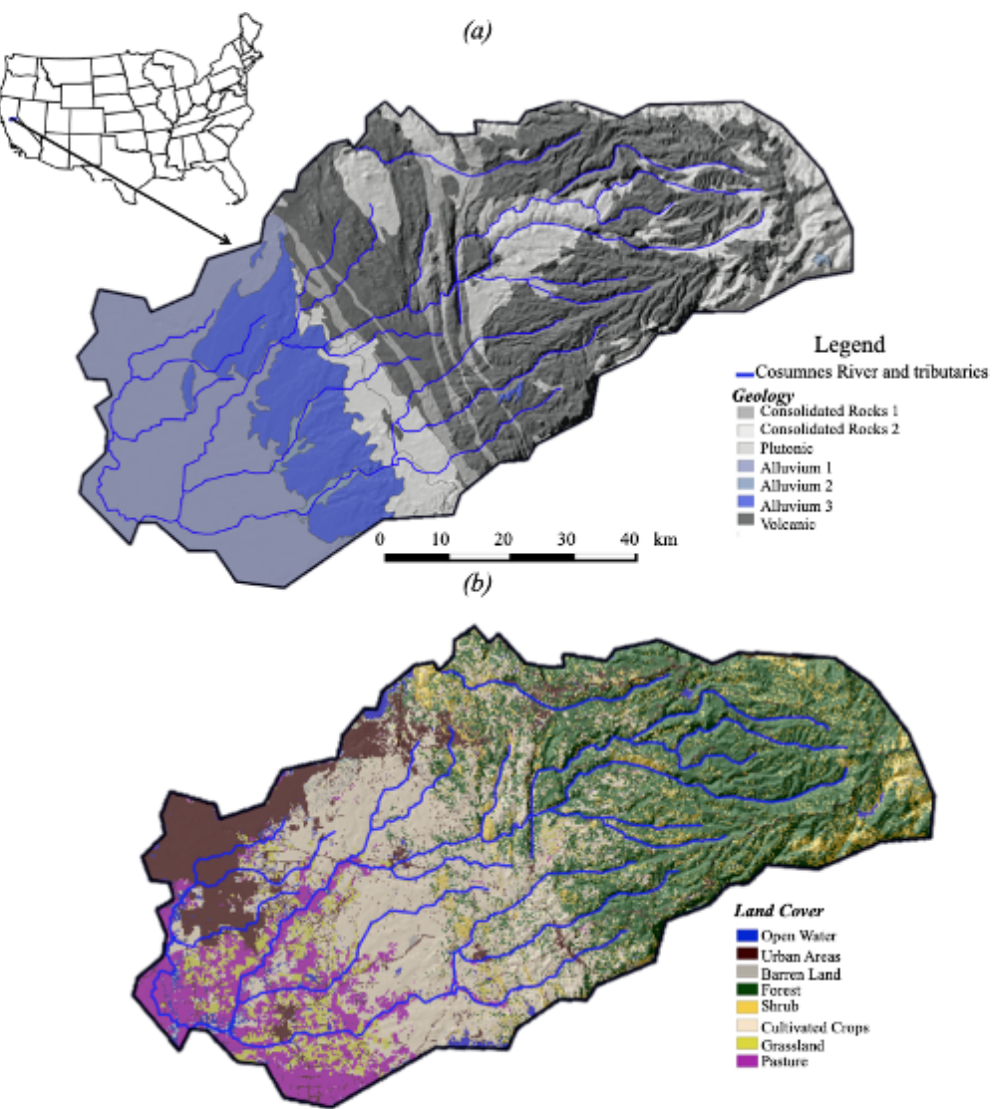
Figure 1. The Cosumnes watershed. (a) Location and geology (Jennings et al., 1977); the alluvium in blue corresponds to the Central Valley aquifers, whereas the consolidated rocks in gray correspond to the Sierra Nevada and cross-cutting marine sediments. (b) Land cover (Homer et al.,